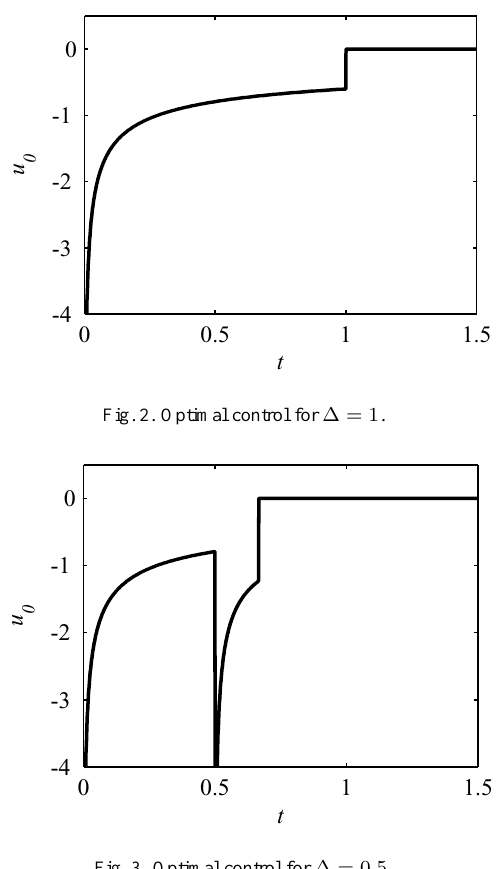
Fig. 3. Optimal control for ∆ = 0 . 5